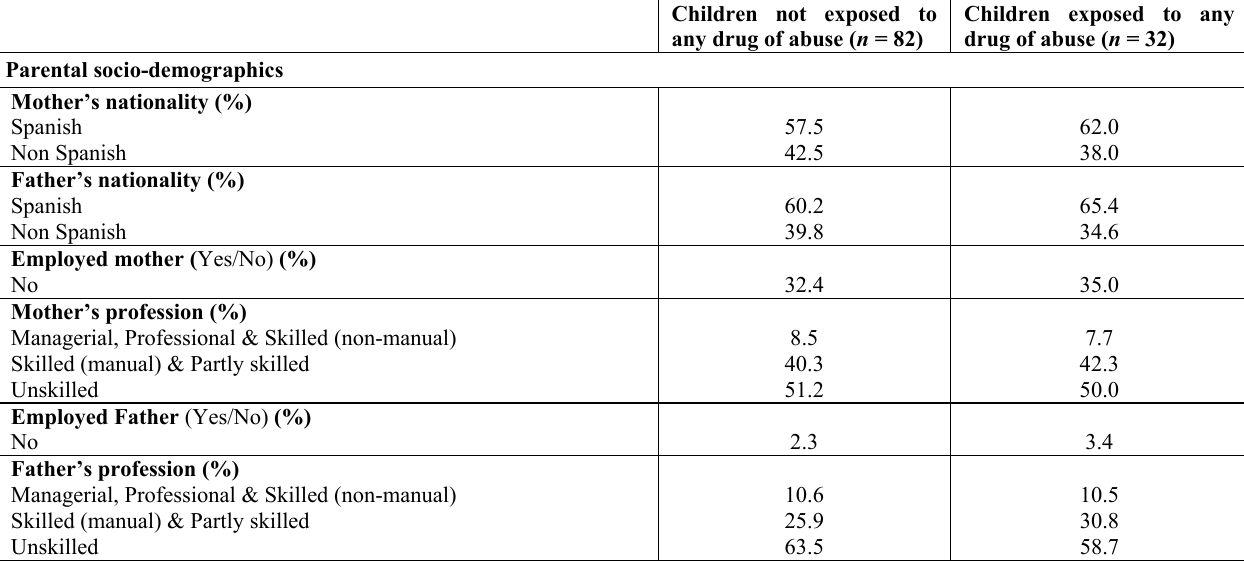
Table 3. Self declared parental sociodemographics and toxic habits for the 114